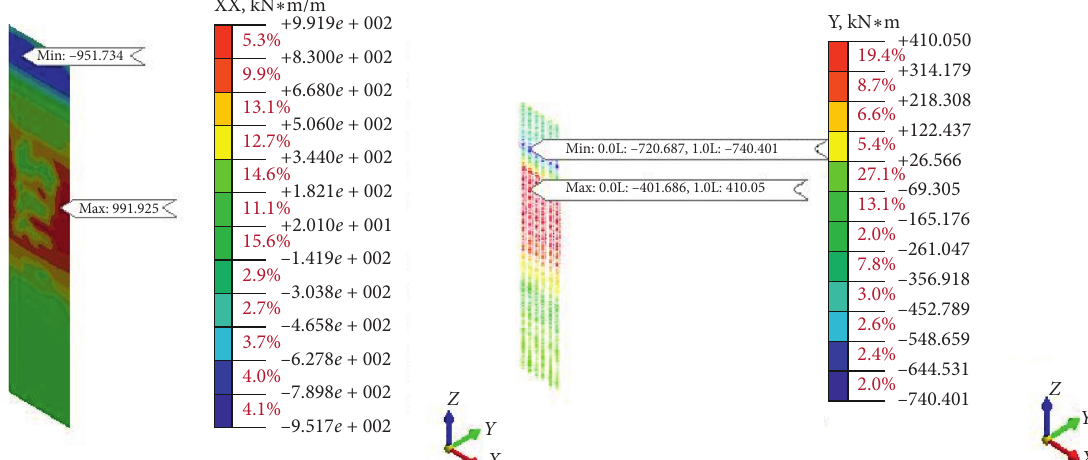
Figure 16: No backfilling of wharf, after excavation of foundation pit to the end, the bending moment per meter of supporting structure (unit: kN ·